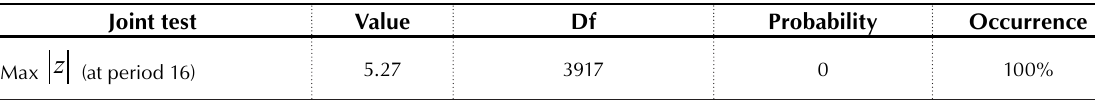
Table 3. Martingale test